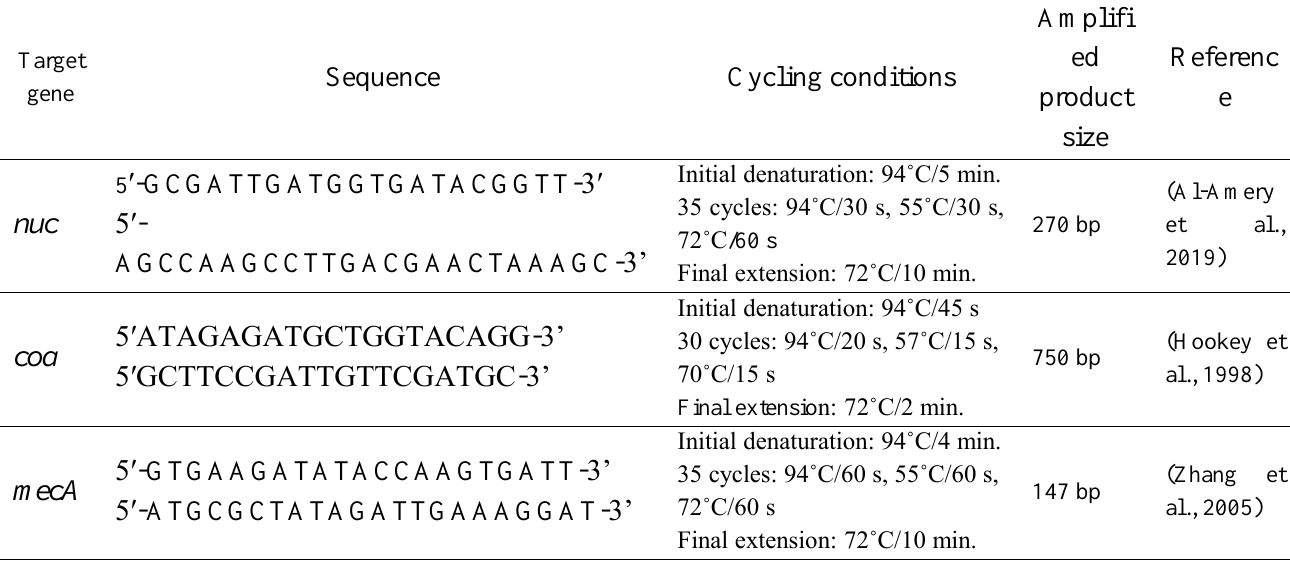
Table 1: Primer sequences and expected product sizes of S. aureus target genes.